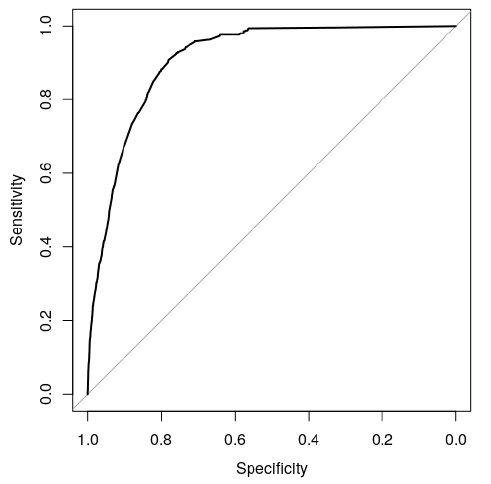
Figure 2. The area under the curve illustrating the performance of the full model to predict mortality by COVID-19. Note the high precision given by the area under the curve (AUC) (95% CI) of 0.909 (0.900;0.919).